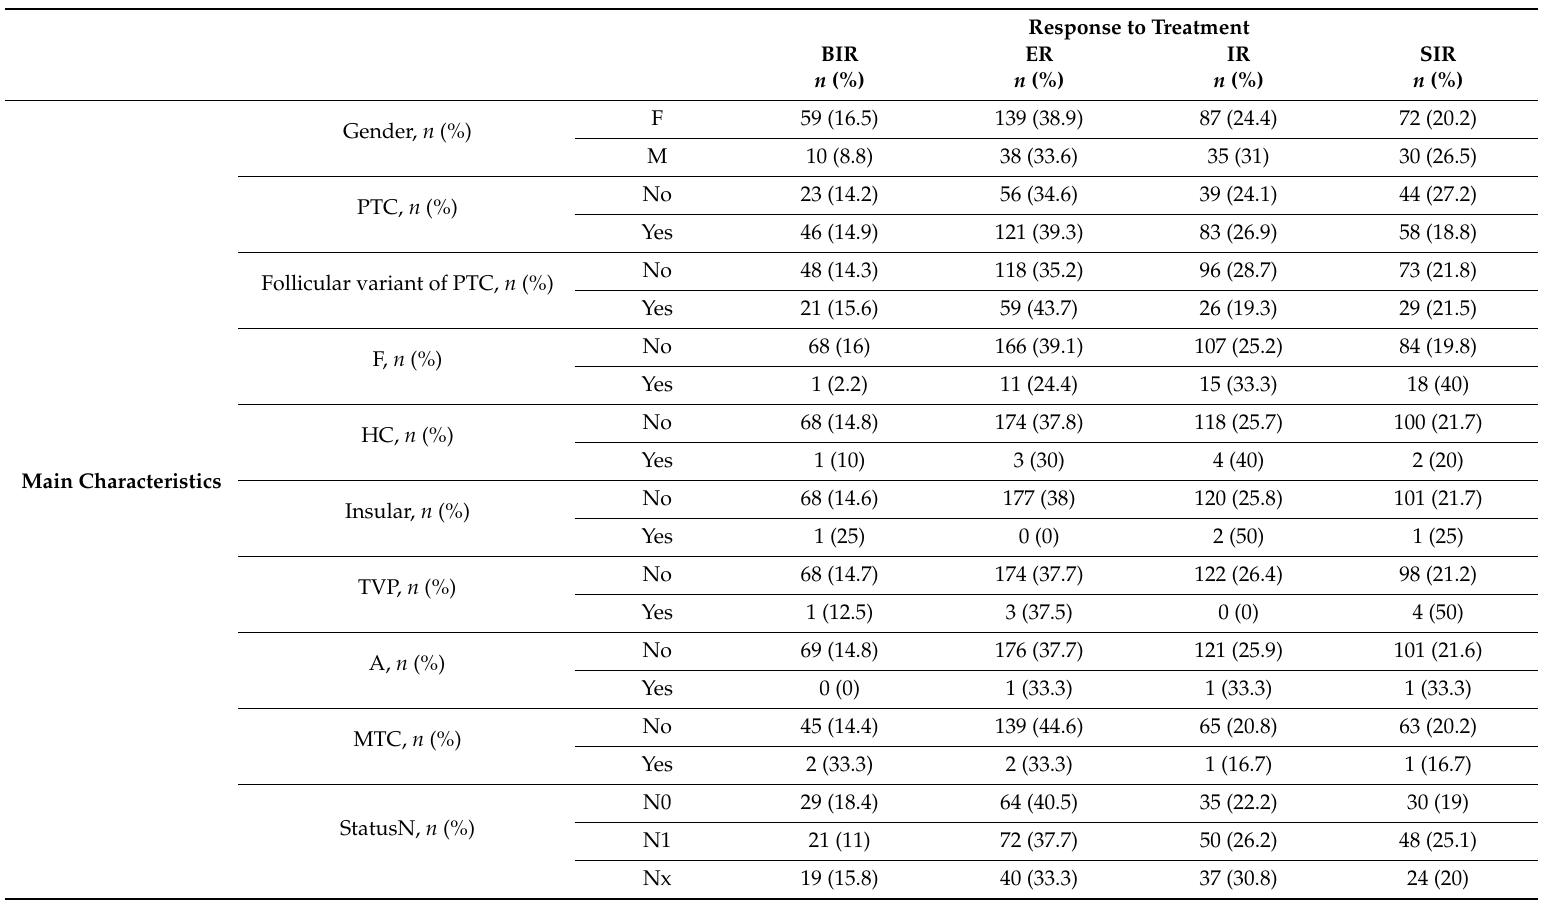
Table 5. Characteristics and response to